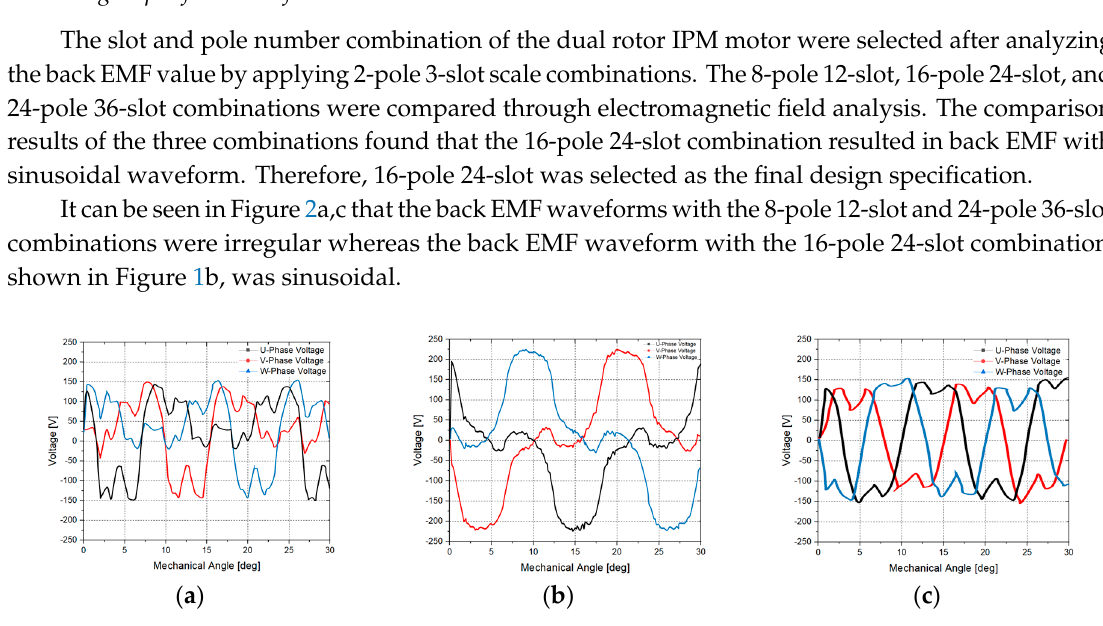
Table 1. Specifications of the dual rotor IPM motor.